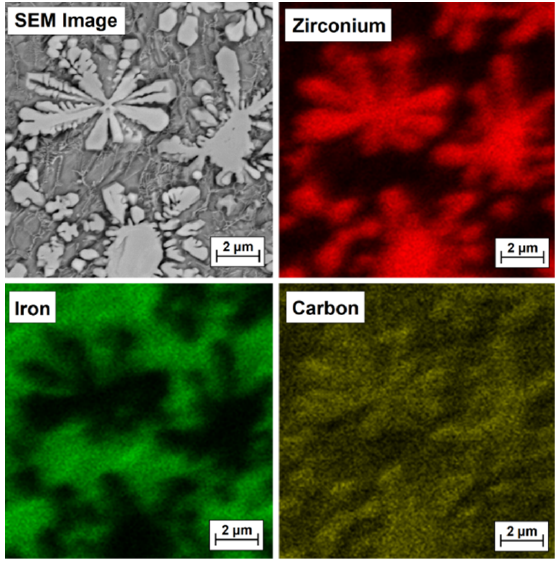
Figure 10. Microstructure and EDS mapping of Fe/ZrC coating produced using a laser beam power of 500 W—middle area of melted zone.